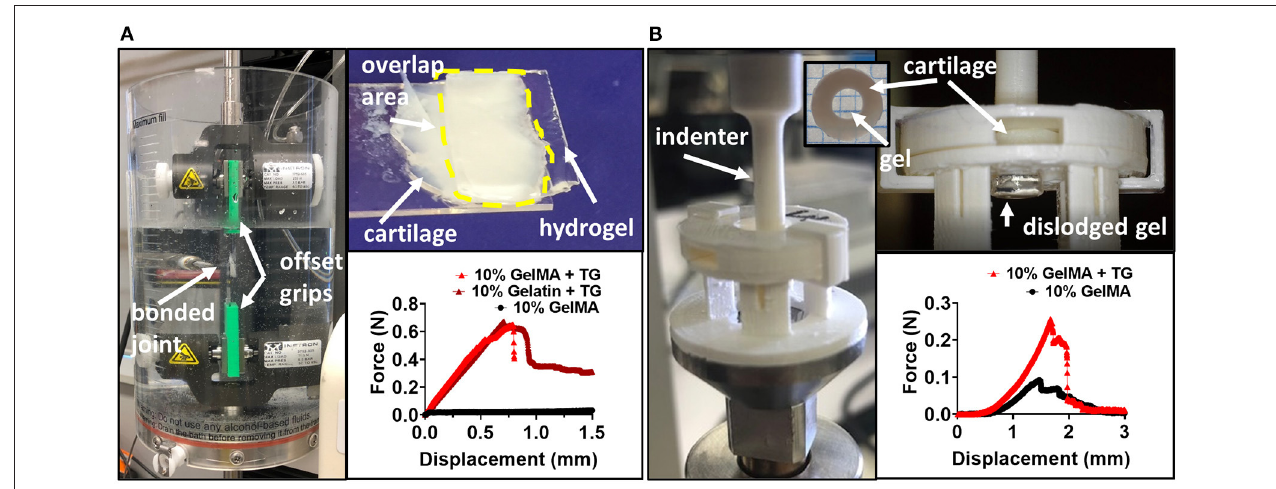
FIGURE 1 | Testing the adhesive ability of GelMA with transglutaminase hydrogels against cartilage tissue (A) Pictures depicting lap shear test (left and top) and representative force-displacement curves for tests. (B) Pictures depicting ex vivo model and push out test (left and top), and representative force-displacement curves for tests with 10% GelMA. For representative force-displacement curves for 8 and 6% GelMA, see Supplementary Figure 5